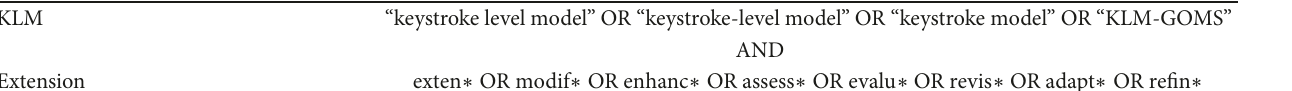
Table 4: Search string used to conduct the review search in the digital libraries. The wildcard ∗ is used to signify any character to include variations for each